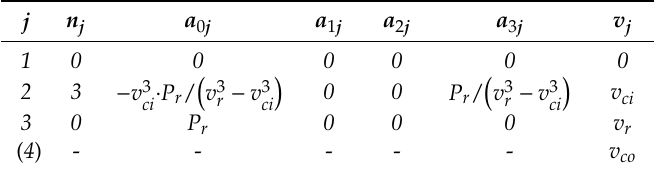
Table 3. Relationship among parameters of the cubic ones and the parameters of the WT.